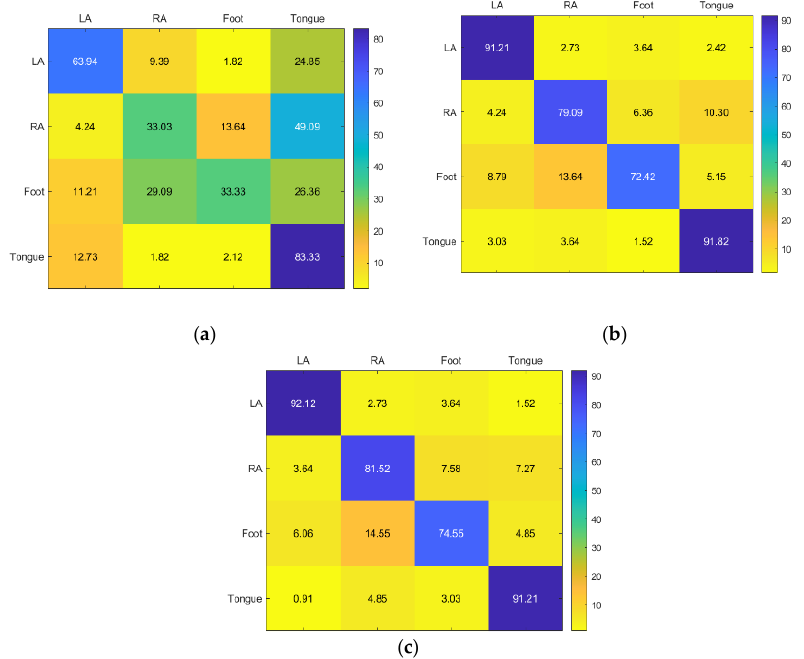
Figure 8. Confusion matrices for the ( a ) KNN, ( b ) SVM, and ( c ) RF classifiers to demonstrate the MI-BCI performance from the first subject’s four classes (left hand, right hand, feet, and tongue).